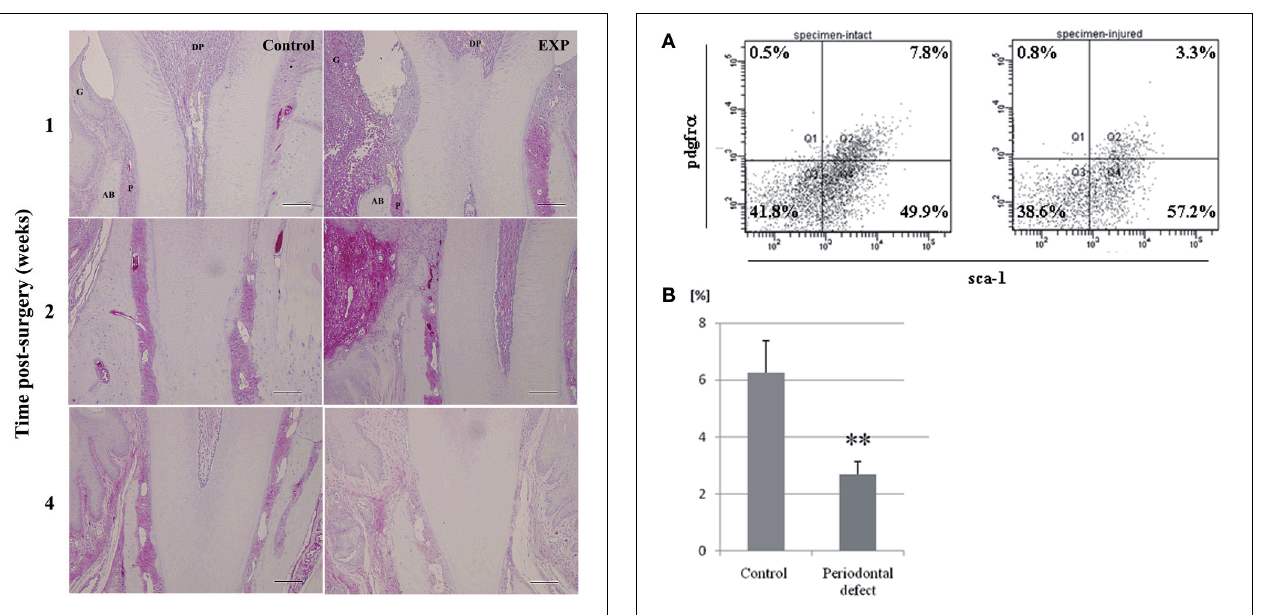
sites in murine periodontal ligament (McCulloch, 1985).